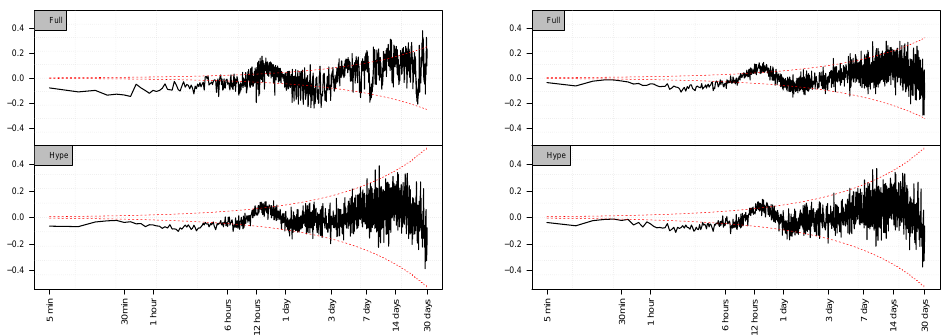
Figure 2. Linear correlation coefficient calculated as a function of the size of the time interval of returns for Bitstamp left and Coinbase right. The horizontal axis is the logarithmic of the time interval.